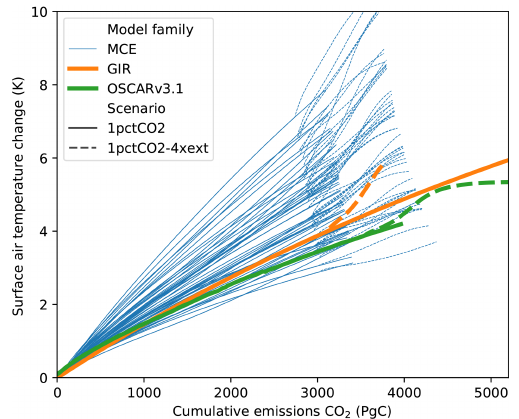
Figure 4. Surface air temperature change against cumulative CO 2 emissions in the 1pctCO2 and 1pctCO2-4xext experiments. Thin lines are used for the MCE model’s family of emulation setups. Thick lines are used for the GIR (since renamed FaIR-v2) and OS- CAR 3 ◦ C climate sensitivity